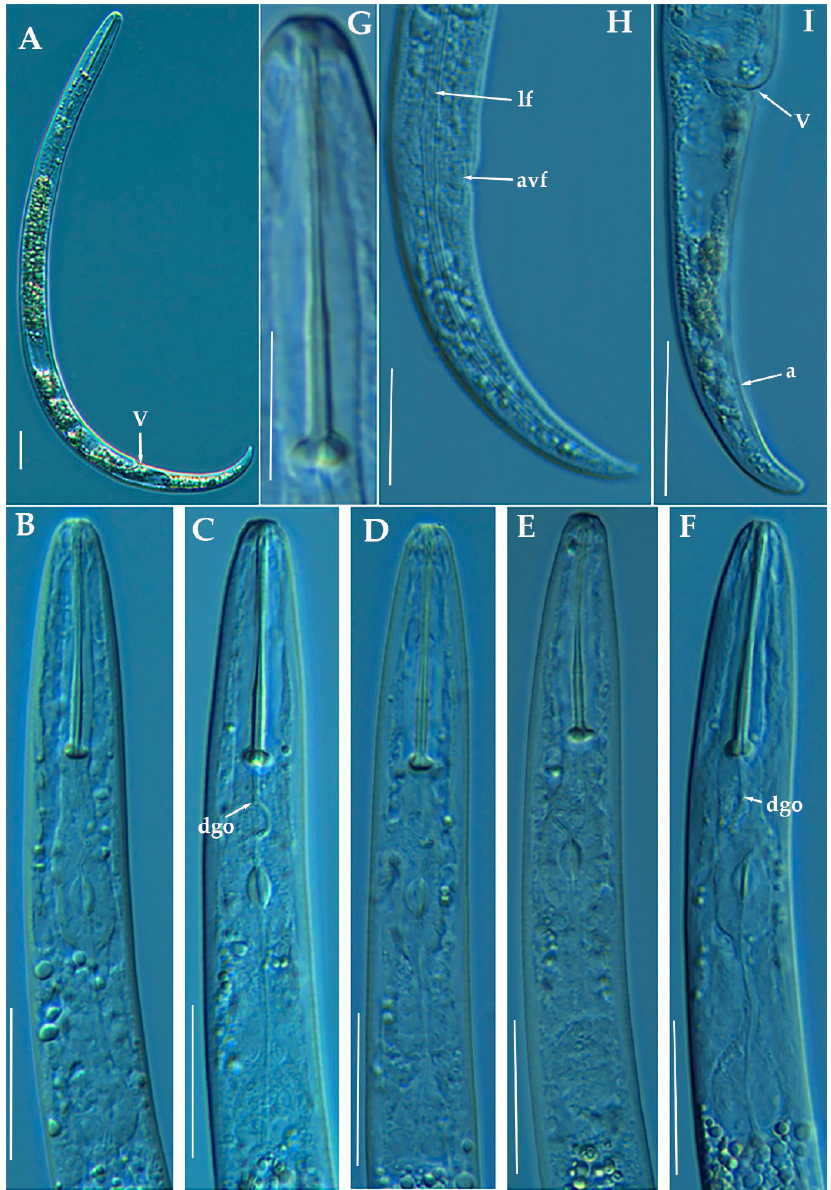
Figure 14. Light photomicrographs of Paratylenchus baldaccii Raski, 1975. ( A ): Entire female with vulva arrowed; ( B – F ): Female pharyngeal region; ( G ): Detail of female stylet; ( H ): Female posterior region showing lateral field and advulval flap (arrowed); ( I ): Female posterior region showing vulva and anus (arrowed). Scale bars ( A – F , H , I = 20 μ m; G = 10 μ m). (Abbreviations: a = anus; avf = advulval flap; dgo = pharyngeal dorsal gland orifice; lf = lateral field; V = vulva).